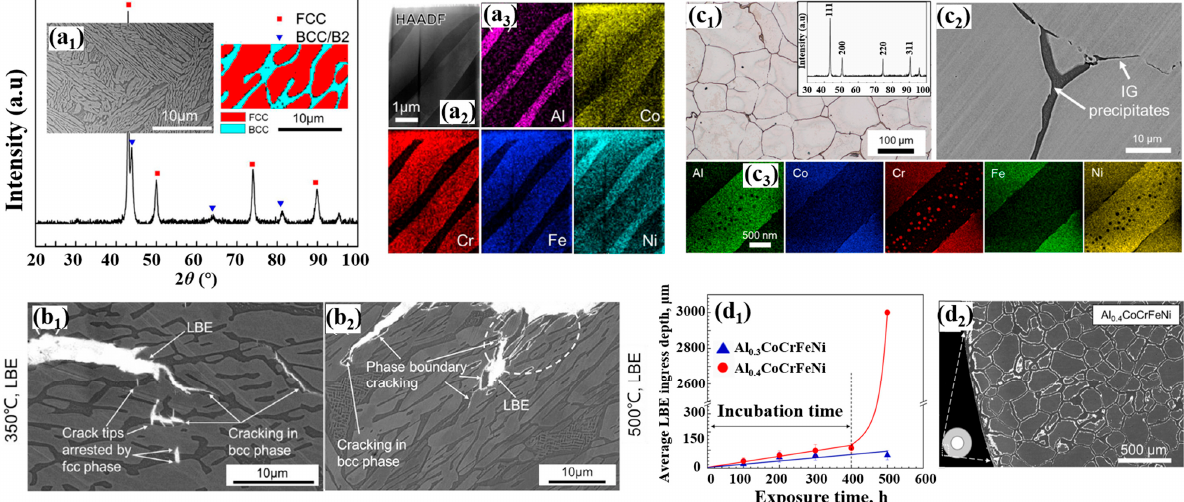
Figure 13. ( a 1 ) SEM image, XRD pattern, and EBSD phase map; ( a 2 ) HAADF morphology and ( a 3 ) EDS elemental distribution of the dual-phase Al 0.7 CoCrFeNi HEA; SEM micrographs of the dual-phase Al 0.7 CoCrFeNi HEA after being immersed in LBE at ( b 1 ) 350 ◦ C and ( b 2 ) 500 ◦ C; ( c 1 ) optical micrograph and XRD pattern of the Al 0.4 CoCrFeNi HEA; ( c 2 ) BSE morphology of intergranular precipitates; ( c 3 ) TEM-EDS maps of the intergranular precipitates; ( d 1 ) the LBE ingress depth at grain boundaries of Al 0.3 CoCrFeNi and Al 0.4 CoCrFeNi HEAs; ( d 2 ) BSE image of the Al 0.4 CoCrFeNi after being immersed in LBE at 500 ◦ C for 500 h [19,96].